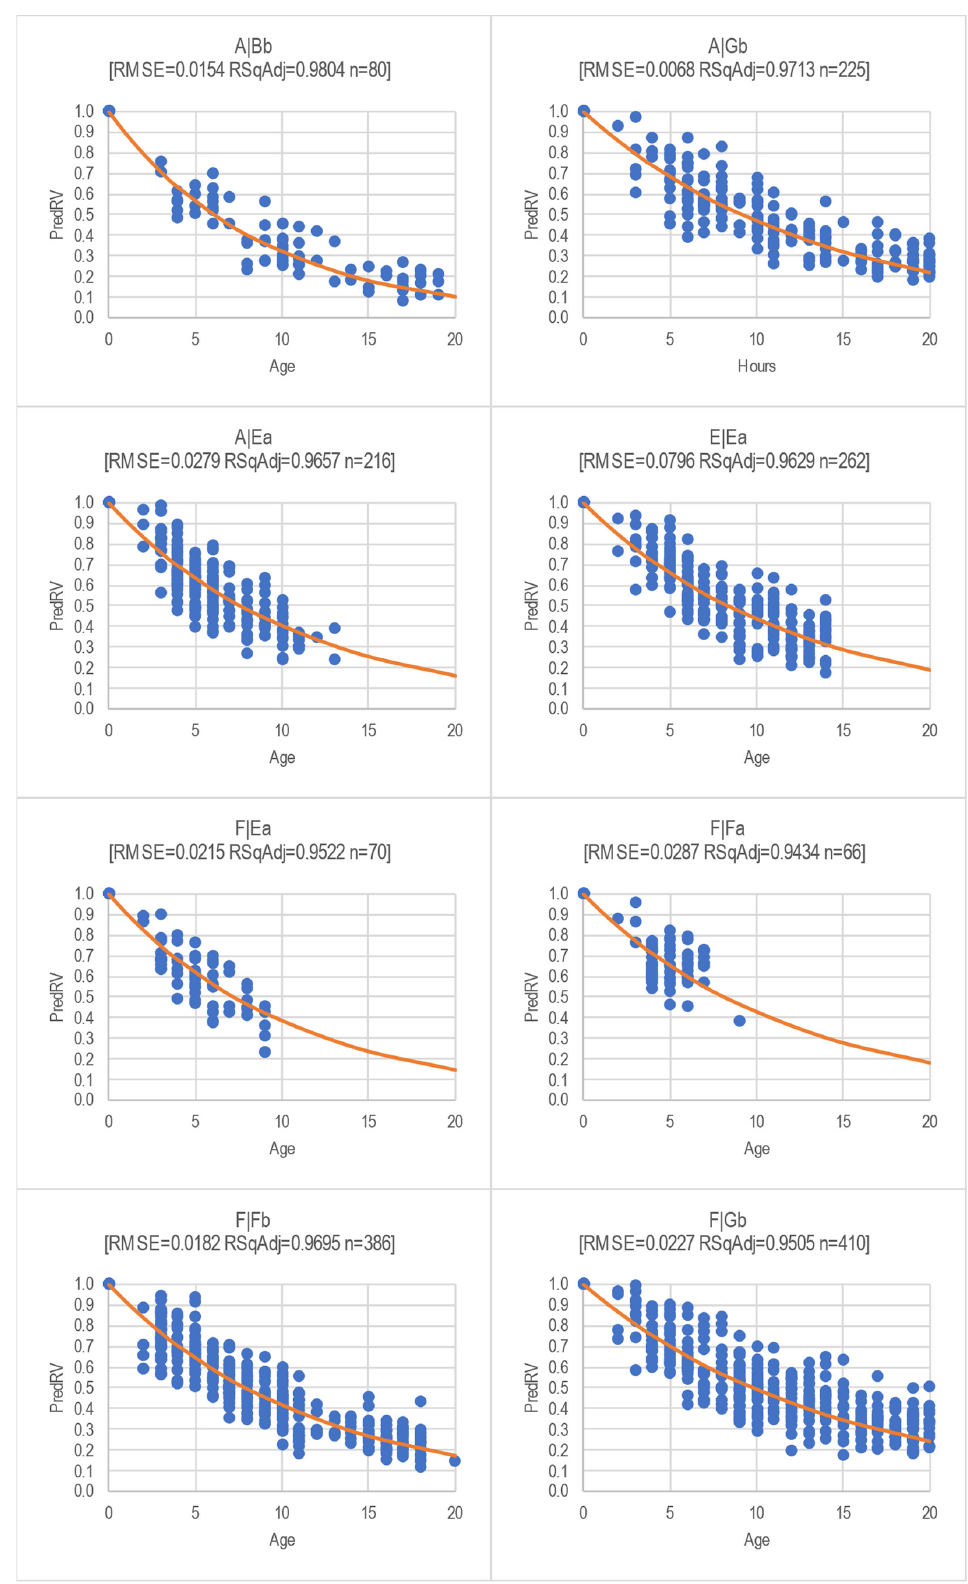
Figure 10. Dataset and power regression for 500 h per year (HPY) results of top eight RMSE tractor Figure 10. families.